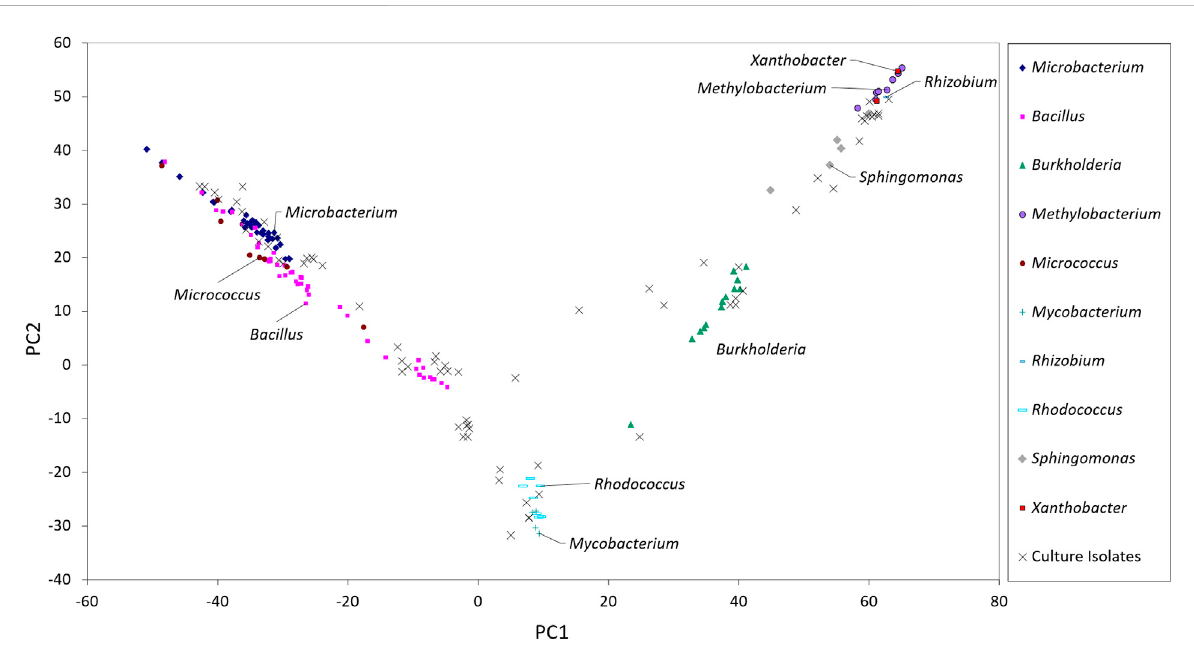
FIGURE 1 Scores of the sampled isolates along the fi rst two axes resulting from PCA of fatty acid composition of selected bacterial genera present in the Sherlock ™ MIS